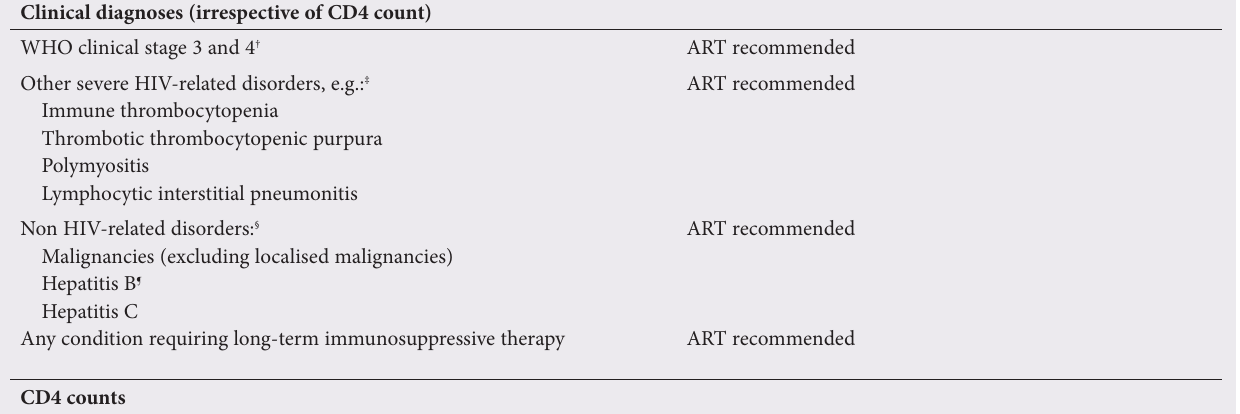
Table 3. Indications for